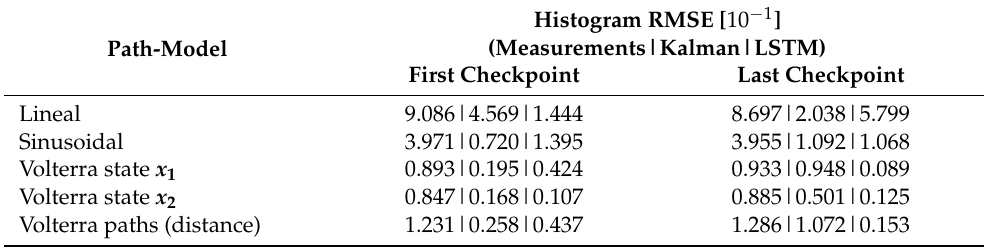
Table 5. Kalman and LSTM validation results.